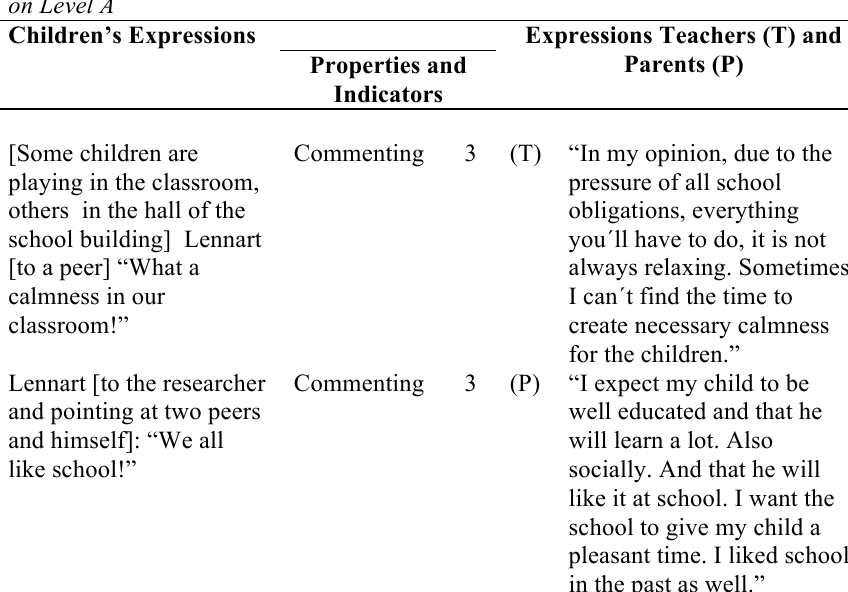
Children’s Expressions Corresponding With a Teacher’s and a Parent’s Expression on Level A